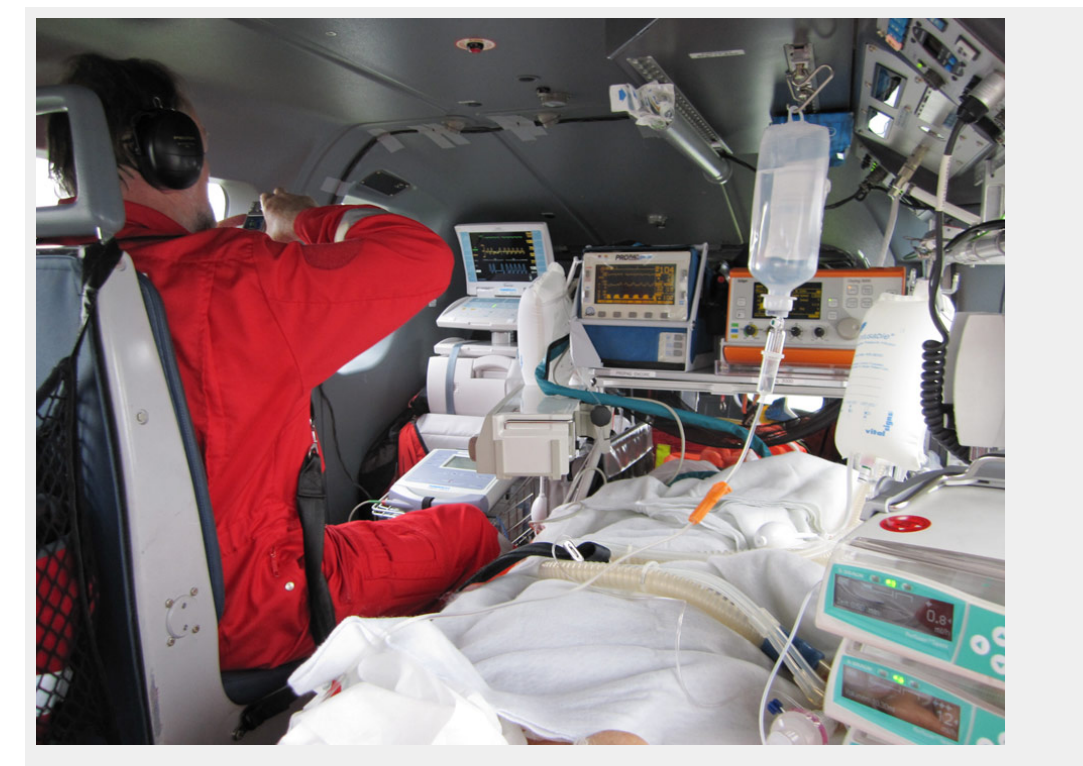
Rear cabin of the EC145 showing dimensions and available space when occupied by a patient and Rega team, including a perfusionist.